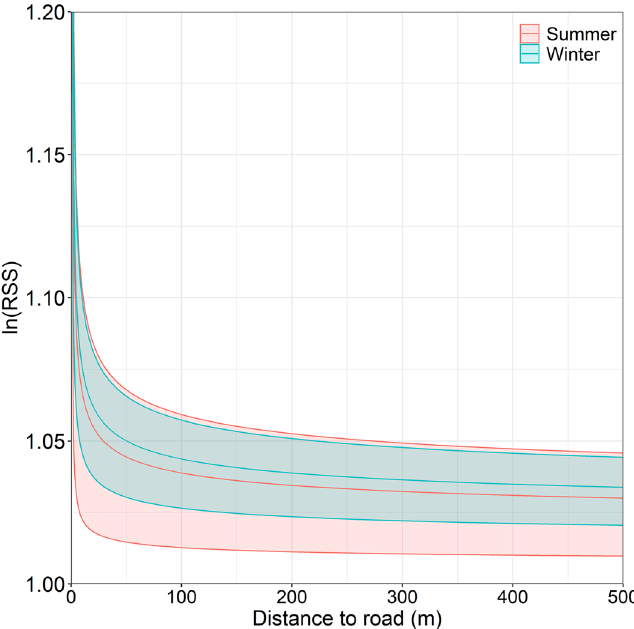
Figure 3. Seasonal wolf log-transformed relative selection strength (RSS) with 95% confidence intervals for distance to linear features (m) in summer (April 1–September 30) and winter (October 1–March 31) for Prince